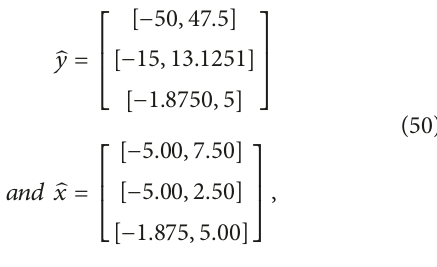
Algorithm 2: Solving linear system of intervals using interval LU